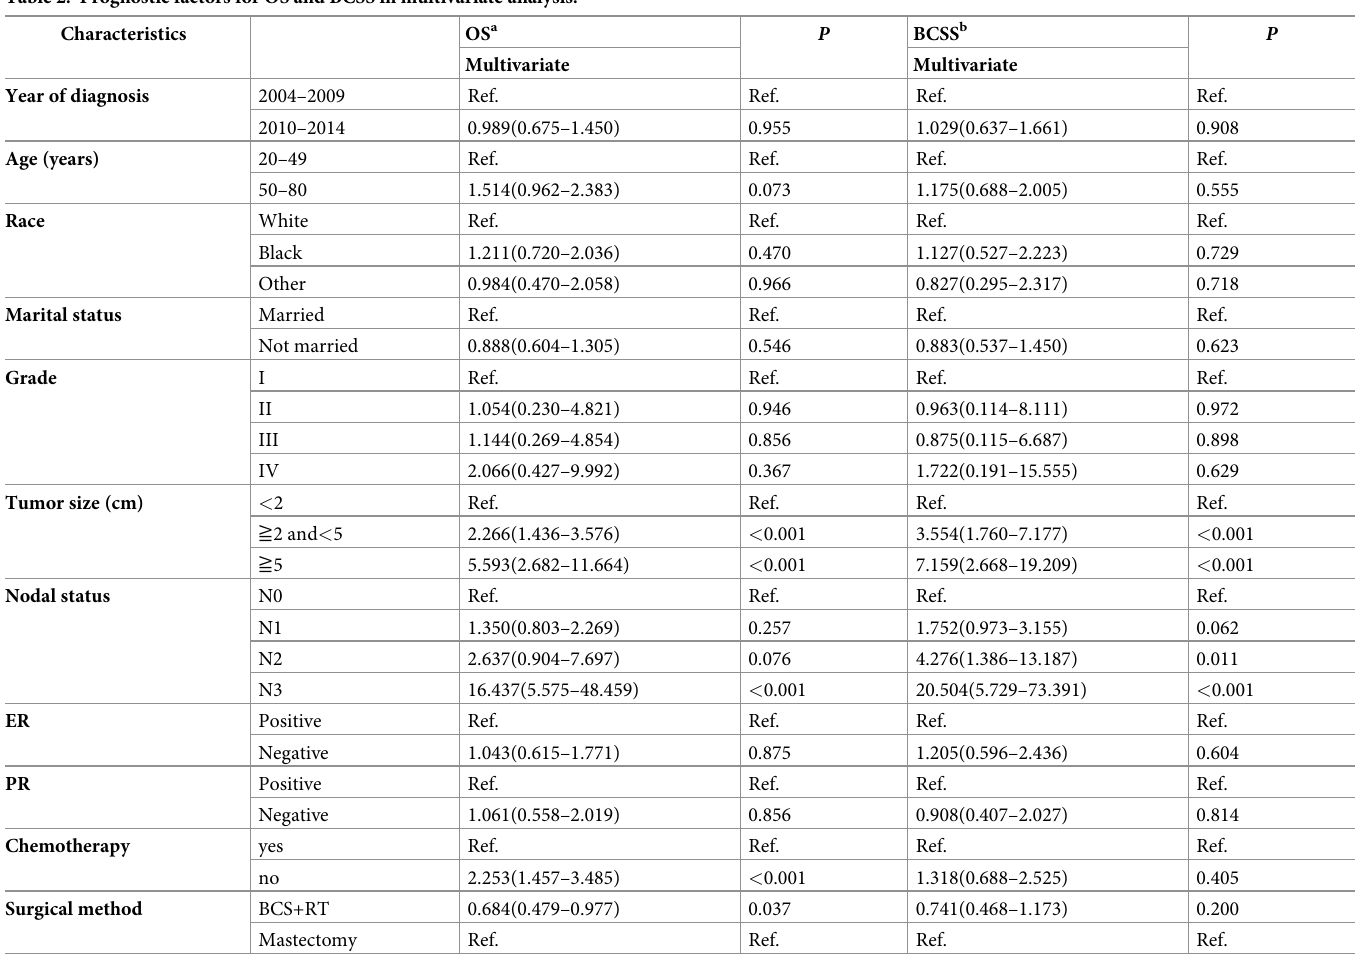
Table 2. Prognostic factors for OS and BCSS in multivariate